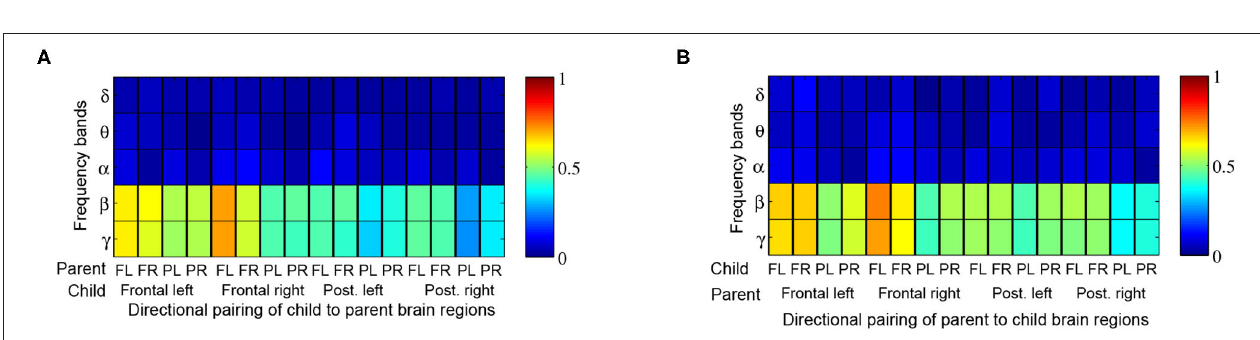
FIGURE 7 | Proportion of child → parent and parent → child directional analyses exhibiting significant Granger influences during music therapy compared to preceding baseline values. Red shading thus denotes 100% of dyads with significant Granger influence. The proportions are tabulated by frequency band (rows) and directional pairing of brain regions, i.e., frontal left (FL), frontal right (FR), posterior left (PL) and posterior right (PR) from (A) child to parent, and (B) parent to child.